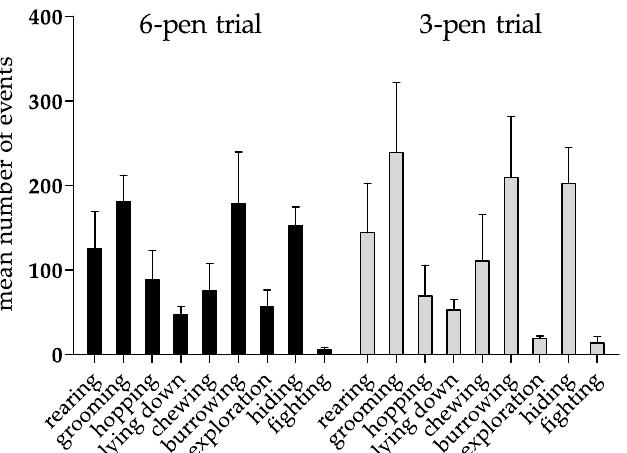
Figure 3. Behavioral pattern of six rabbits first investigated in the 6-pen trial for four weeks and afterwards in the 3-pen trial for an additional four weeks. Data are displayed as arithmetic means + SEM. Mean number of events counted over a period of four weeks in the 6-pen/3-pen trials ( n = 6 animals per trial). Parametric data were analyzed by one-way repeated measure ANOVA. The test revealed no significant differences between different trials.